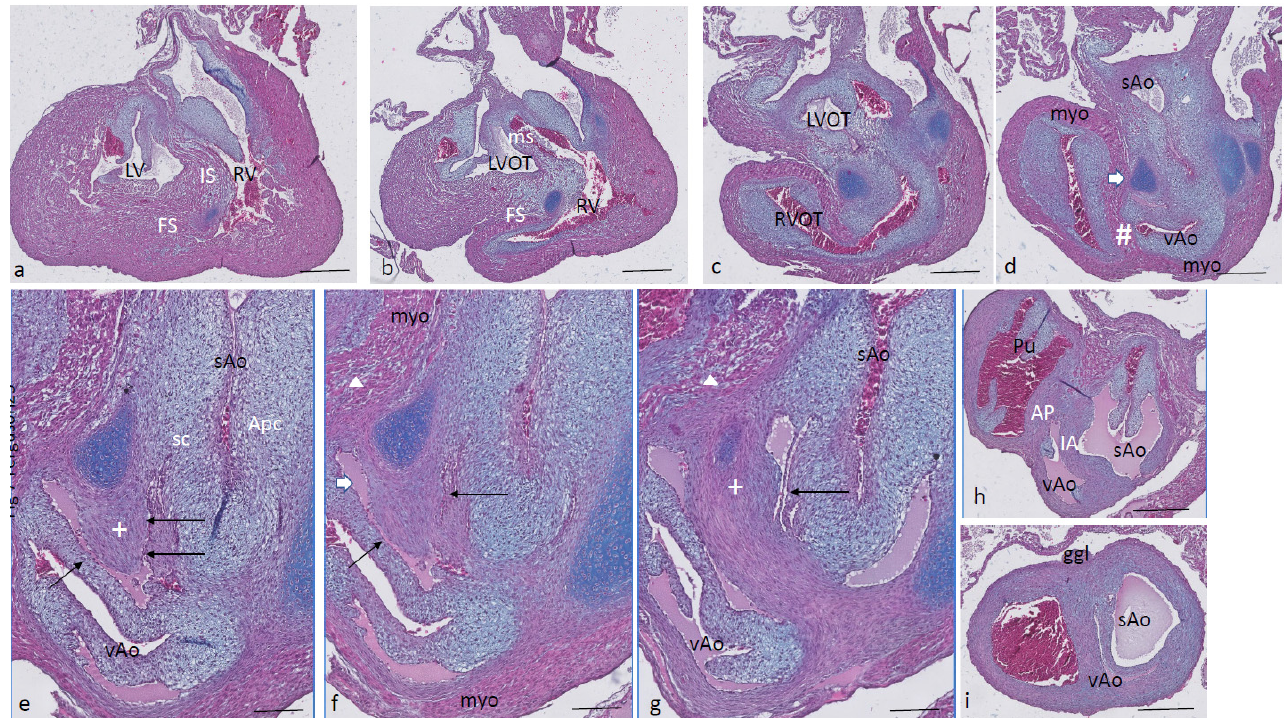
Figure 7. Ferguson stage 25, Figure ( a – i ), from AV to semilunar valve leaflets. The myocardium of this specimen is more compact compared to the earlier stages described here. Figure ( a , b ), the left and right ventricular compartments are completely septated by the combination of the folding septum, inlet septum and mesenchymal septum. Figure ( c , d ), the left and right ventricular outflow tracts and the ensuing arterial trunks are separated by the AP septum and the IA septum. The aortic parietal cushion contains two cartilaginous elements. Figure ( e , f ) show the narrow tunnel of the foramen of Panizza (arrows) through the IA septum (+). Figure ( g ), the IA septum at this level is uninterrupted, with the flanking sinus of Valsalva of the visceral and systemic aortas. Figure ( h , i ), both AP and IA septa are obvious, and the lumen of the visceral aorta is very narrow in this specimen. Key to the symbols # ventral myocardium, part of AP septum; * (presumably) left-sided neural crest cells, part of AP septum; + (presumably) right-sided neural crest, part of IA septum; Δ dorsal myocardium, part of AP septum. Magnification Figure ( a – d , h , i ), bar 500 µm; ( e – g ), bar 200 µm.